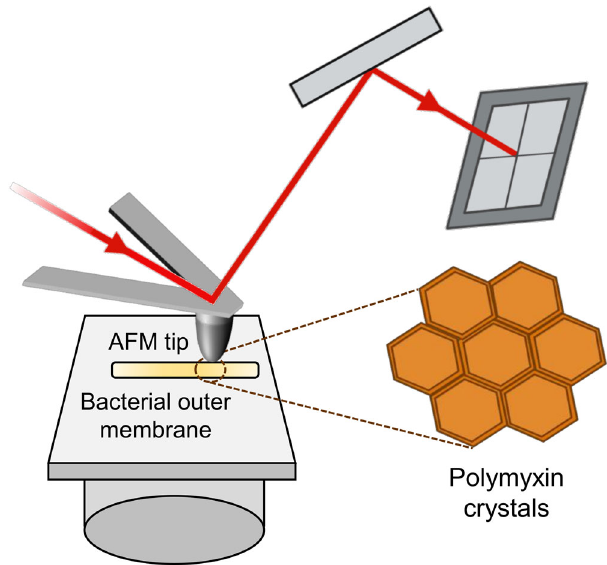
Fig. 1 | In AFM imaging a sample is scanned with a sharp tip attached to a soft cantilever whose up- and down-deformations are detected by a laser- photodiode system. Such AFM imaging has resolved the nanoscale crystal lattice formed by polymyxin in the bacterial outer